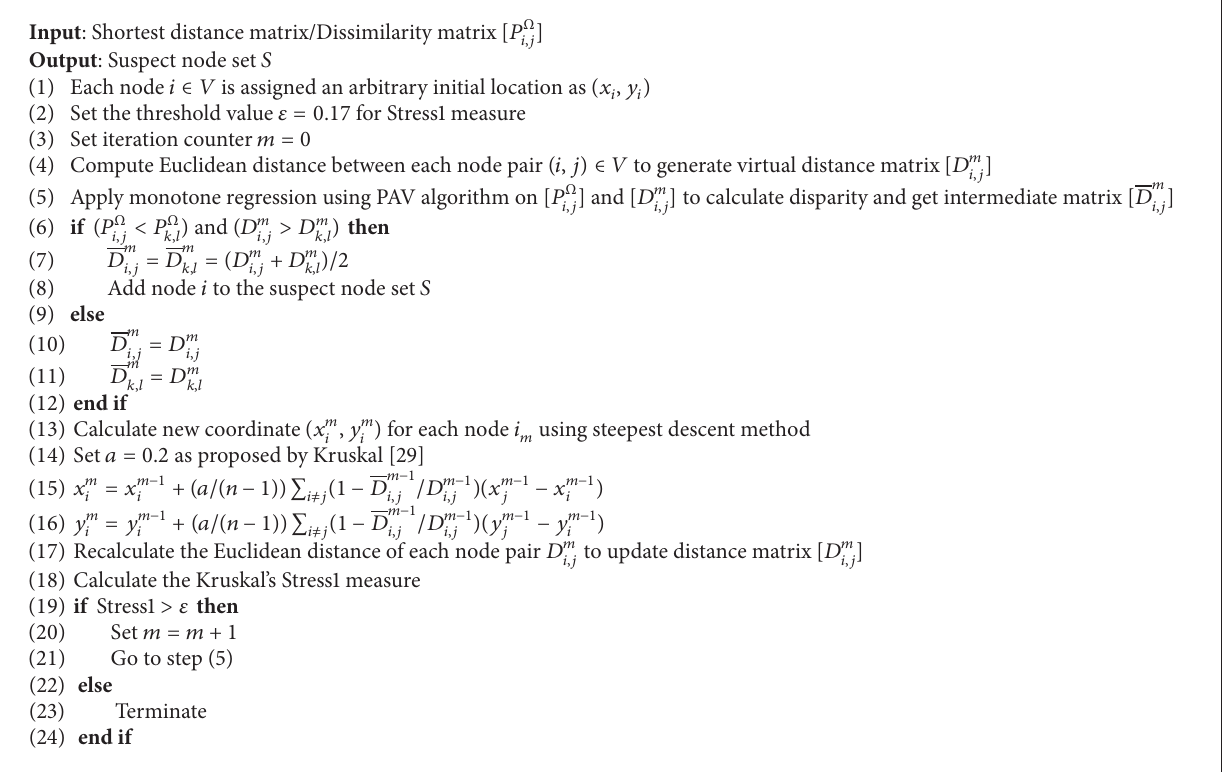
Algorithm 2: Steps of ordinal MDS algorithm for suspect node set.